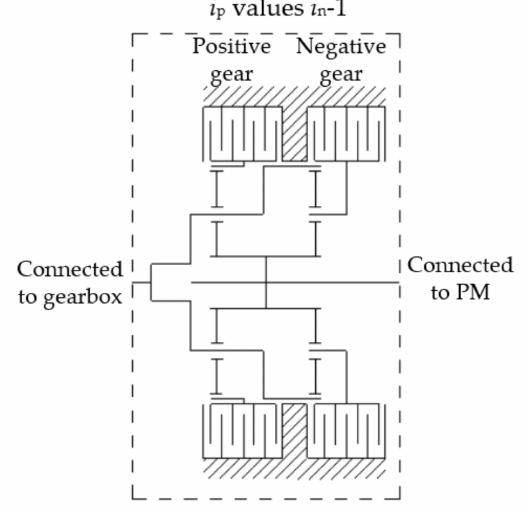
Figure 12. Transmission diagram